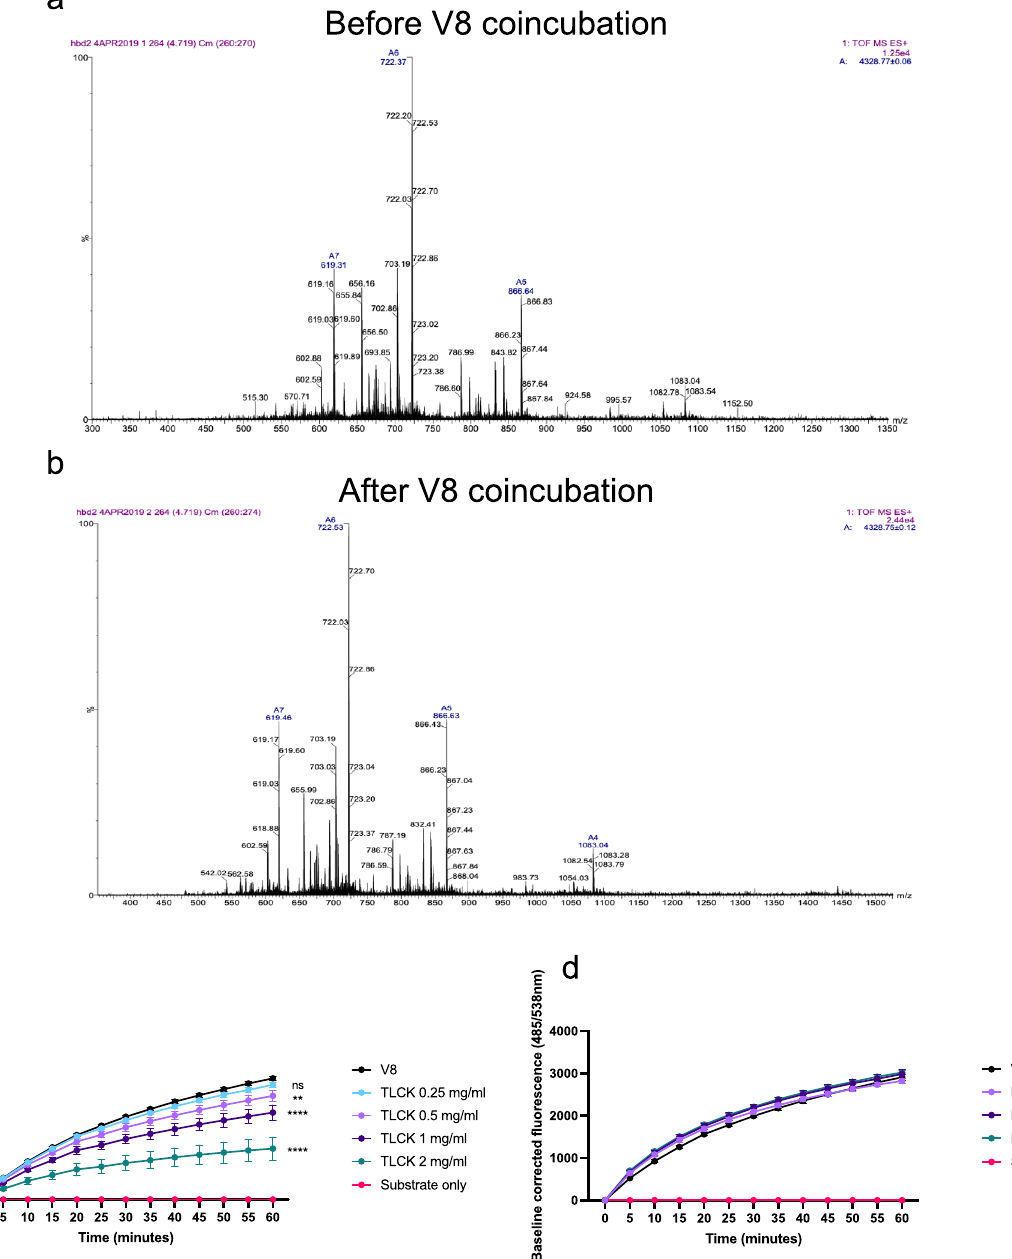
Figure 2. HBD2 does not act as an alternative substrate for V8. ( a , b ) Accurate mass measurements of synthetic HBD2 (100 µg/ml) before ( a ) and after ( b ) 1-h coincubation with V8 (12.5 µg/ml). Peptides were electrosprayed at a concentration of 50 µg/ml from a solution of 50:49:1 water/methanol/acetic acid (v/v/v). ( c , d ) FITC- labelled casein substrate was used to measure proteolytic activity of V8 in the presence or absence of either ( c ) 0.25–2 mg/ml TLCK or ( d ) 25–100 μg/ml HBD2. Fluorescence was measured at 485/538 nm every 5 min for 1 h and corrected by subtraction of the background fluorescence from the 0-min timepoint. HBD2 data were also normalized for low level HBD2 autofluorescence. 12.5 μg/ml V8 and 5 μg/ml substrate were used throughout. Data represents mean ± SEM for n = 5. Statistical analysis using Mann–Whitney test of final timepoints. *** p <